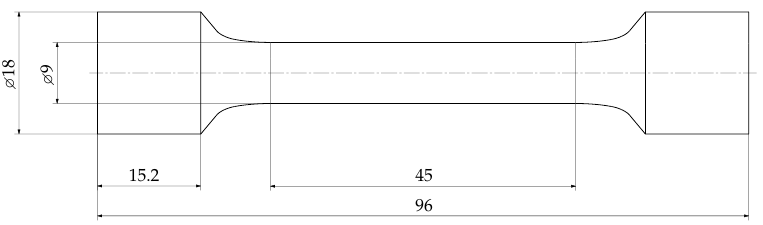
Figure 3. HCF specimen geometry B.